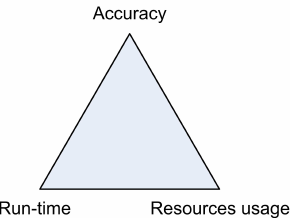
Fig. 6 Approximate computing trades-off accuracy with run-time and resources.